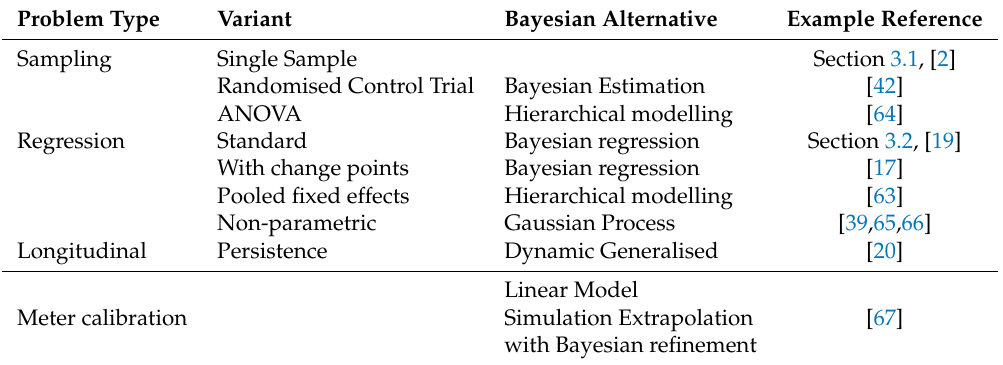
Table 4. Common M&V (Measurement and Verification) cases and their Bayesian